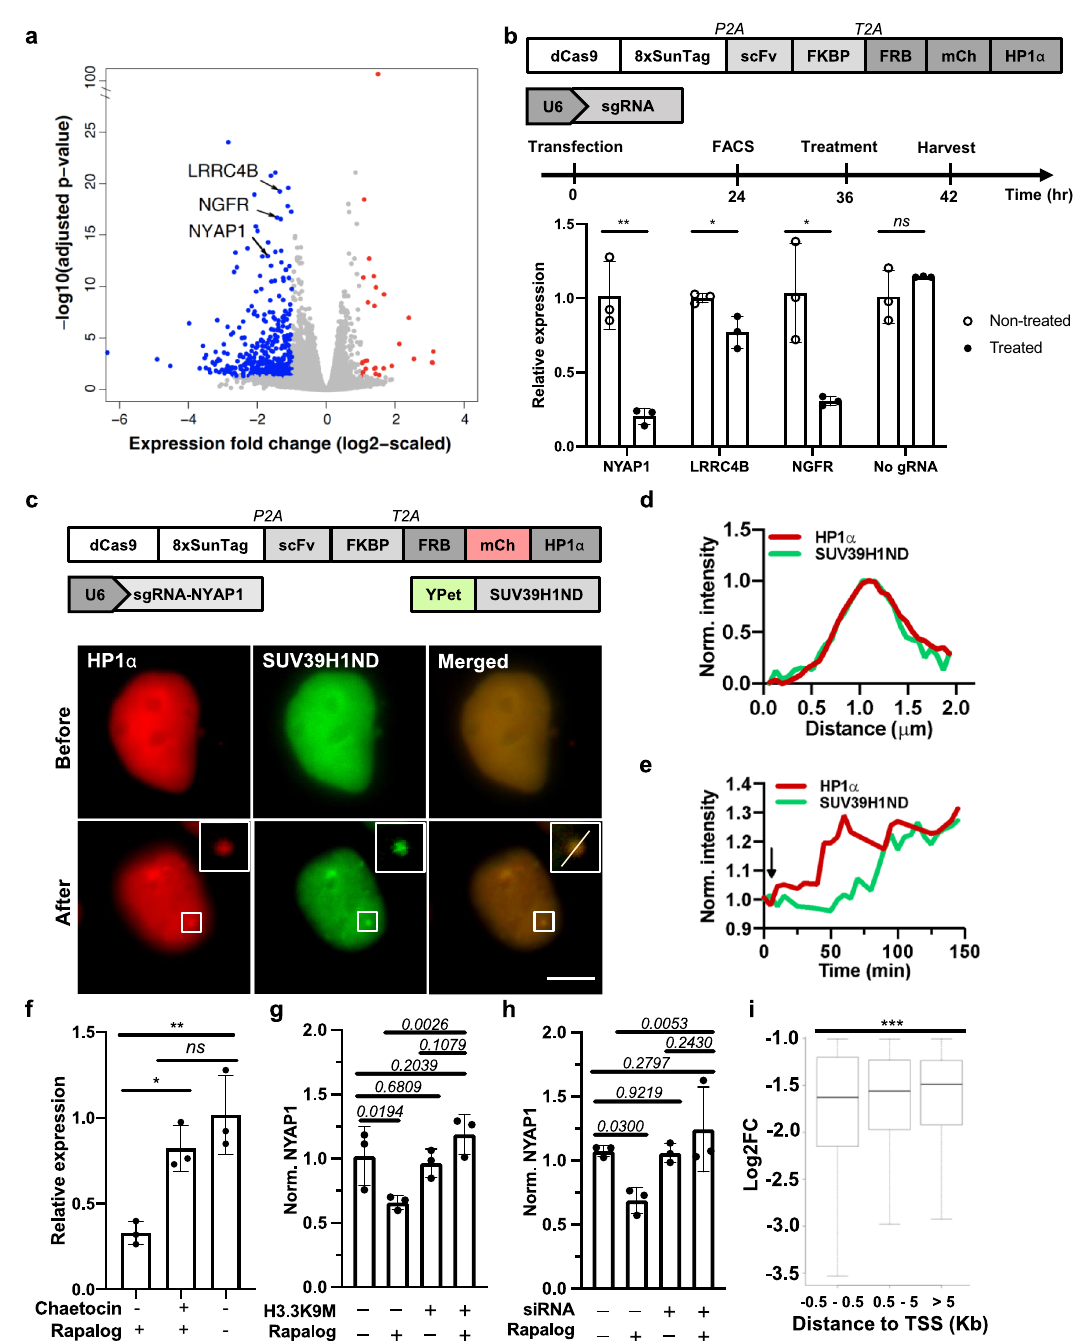
Fig. 5 | SIMBA recruits histone methyltransferase to regulate local transcrip- tion at target genomic sites. a Volcano plot of HP1 α -mediated transcriptomic changes at NFAT1 binding sites (Benjamini corrected P -value, P adj <0.05). NYAP1 , NGFR , and LRRC4B selectedforfollowing validationassays. Differentiallyregulated genes shown in blue (downregulated) and red (upregulated). b The CRISPR/ dCas9 system targets the three endogenous genes in HEK293T cells. qPCR results showtherelativeexpression(n=3biologicallyindependentexperiments,unpaired two-sidedStudent ’ s t test. NYAP1 : p =0.0039; LRRC4B : p =0.0244; NGFR : p =0.0191; No gRNA: p =0.2662.) c Live cell imaging shows co-localization of HP1 α and SUV39H1N-terminaldomain(SUV39H1ND)at NYAP1 locusbeforeandafterrapalog treatment (insets: enlarged images of the indicated BAs with enhanced clarity by applying more stringent brightness/contrast settings). Scale bar, 5 μ m. d The puncta highlighted by the white box in ( c ) was quanti fi ed based on normalized intensities. e Dynamic fl uorescenceintensitychangeofHP1 α (red)andSUV39H1ND